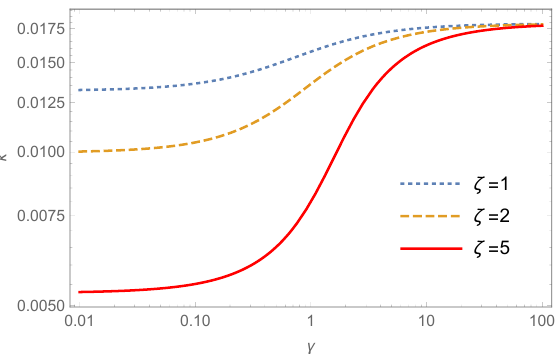
Figure 4 . The dependence of the transition rate of the Hawking-Page phase transition from the large SAdS black hole state to the thermal AdS state on the decay coefficient γ for the exponentially decayed friction kernel. In the plot, L = 1 , and T = 0 . 5